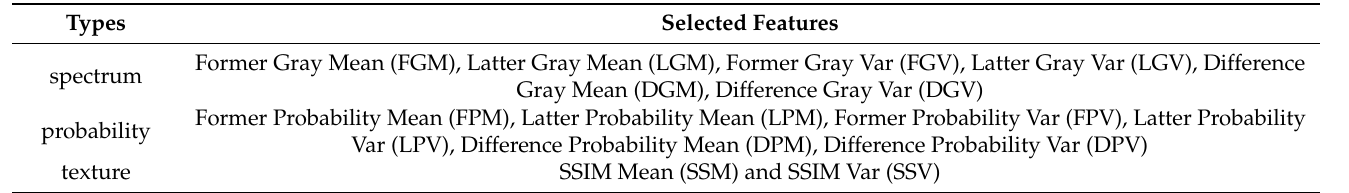
Table 1. Feature Selection